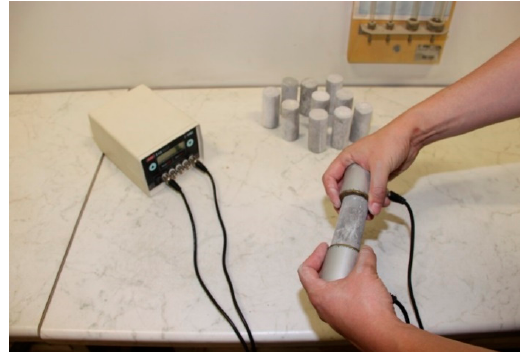
Figure 6. Conduction of ultrasound testing on grout samples.